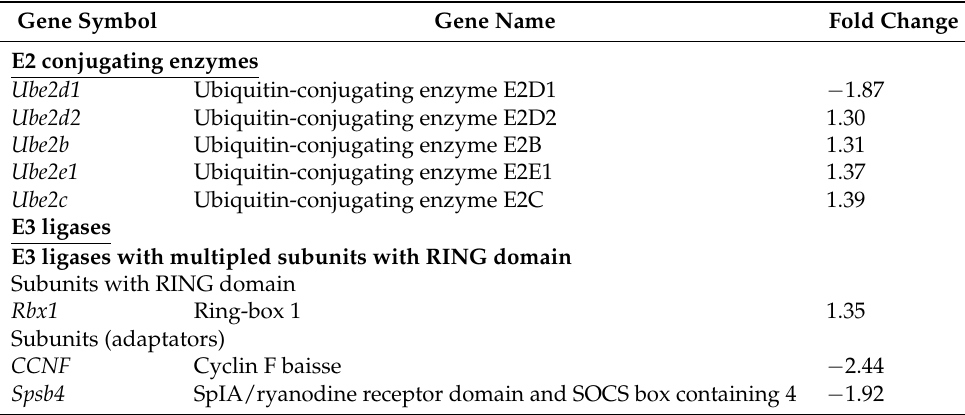
Table 2. Gene of the ubiquitin (Ub)/Ub-like family differentially expressed in NSC-34